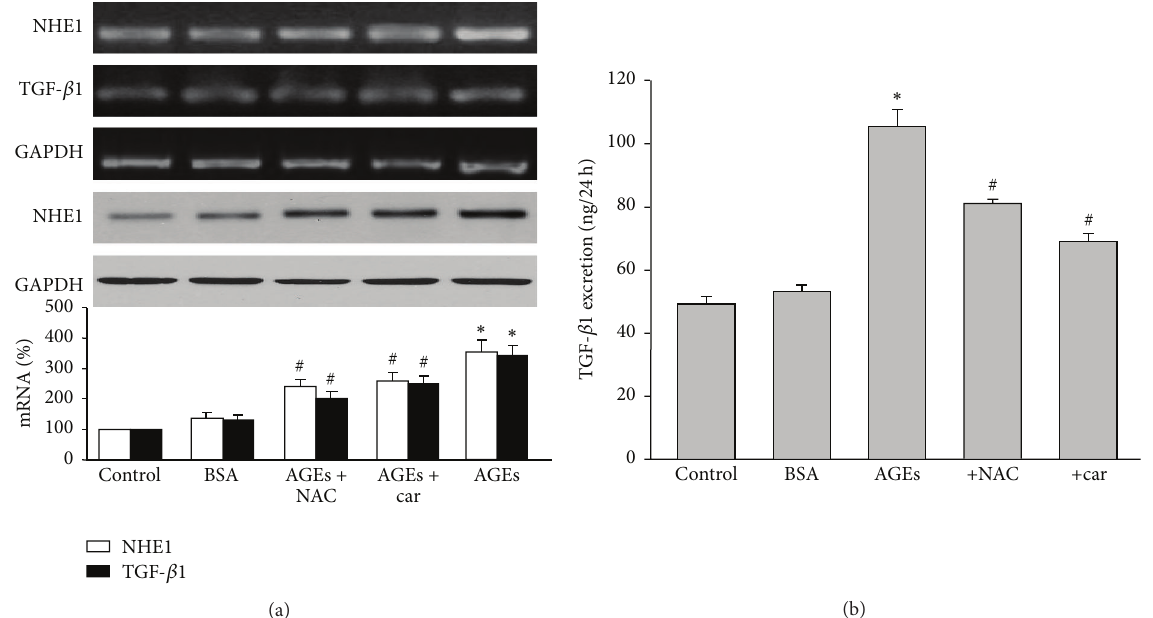
Figure 6: Cariporide reduces the gene expressions of NHE1 and TGF- 𝛽 1 in renal cortex from AGEs-injected rats. The rats received a tail vein injection of AGEs (100mg/kg) followed by treatment with or without N-acetylcysteine (200 mg/kg/day) or cariporide (1mg/kg/day) for 12 weeks. At the end of experiments, rats were sacrificed under anesthesia. (a) mRNA levels of NHE1 and TGF- 𝛽 1 and protein level of NHE-1 were assayed by RT-PCR or Western blot. (b) TGF- 𝛽 1 excretion of rat urine. All data were expressed as mean ± SD. 𝑁 is 10–15 in each group. ∗ 𝑃 < 0.05 versus BSA. # 𝑃 < 0.05 versus AGEs